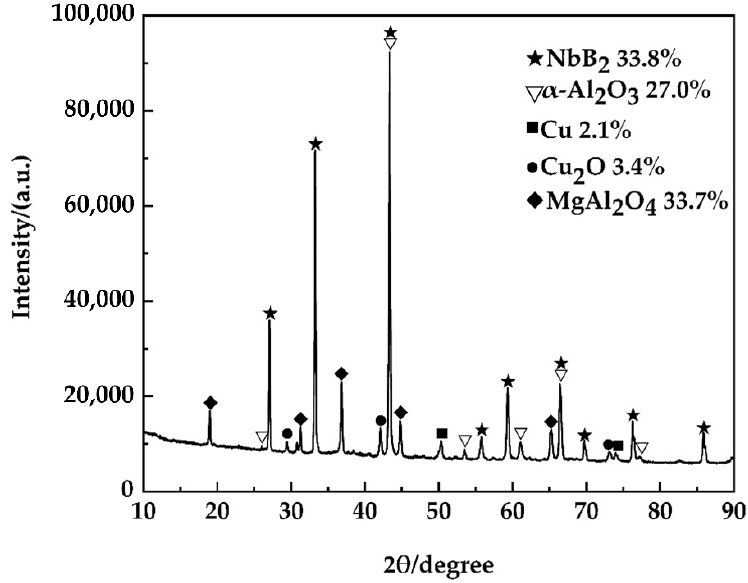
Figure 6. The XRD pattern of an acid ‐ etched powder sample.